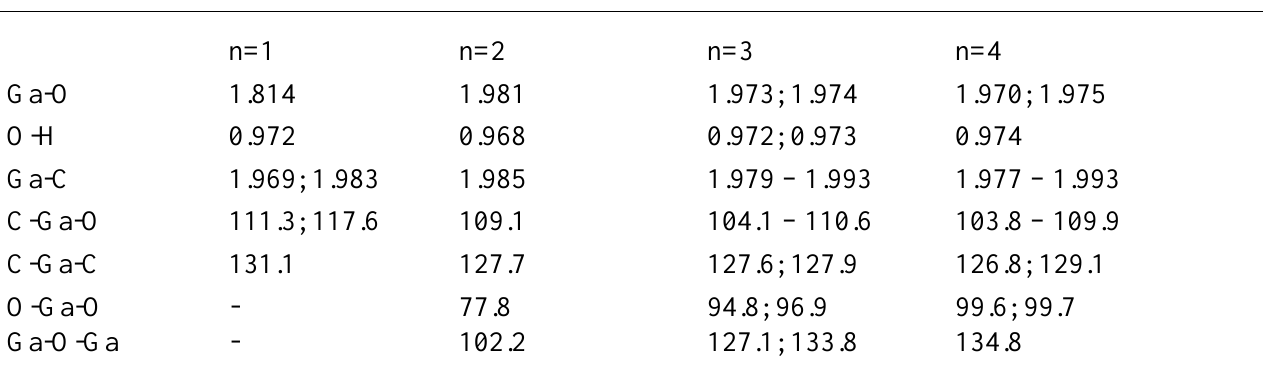
Ga( µ -OH)] from DFT 2 n